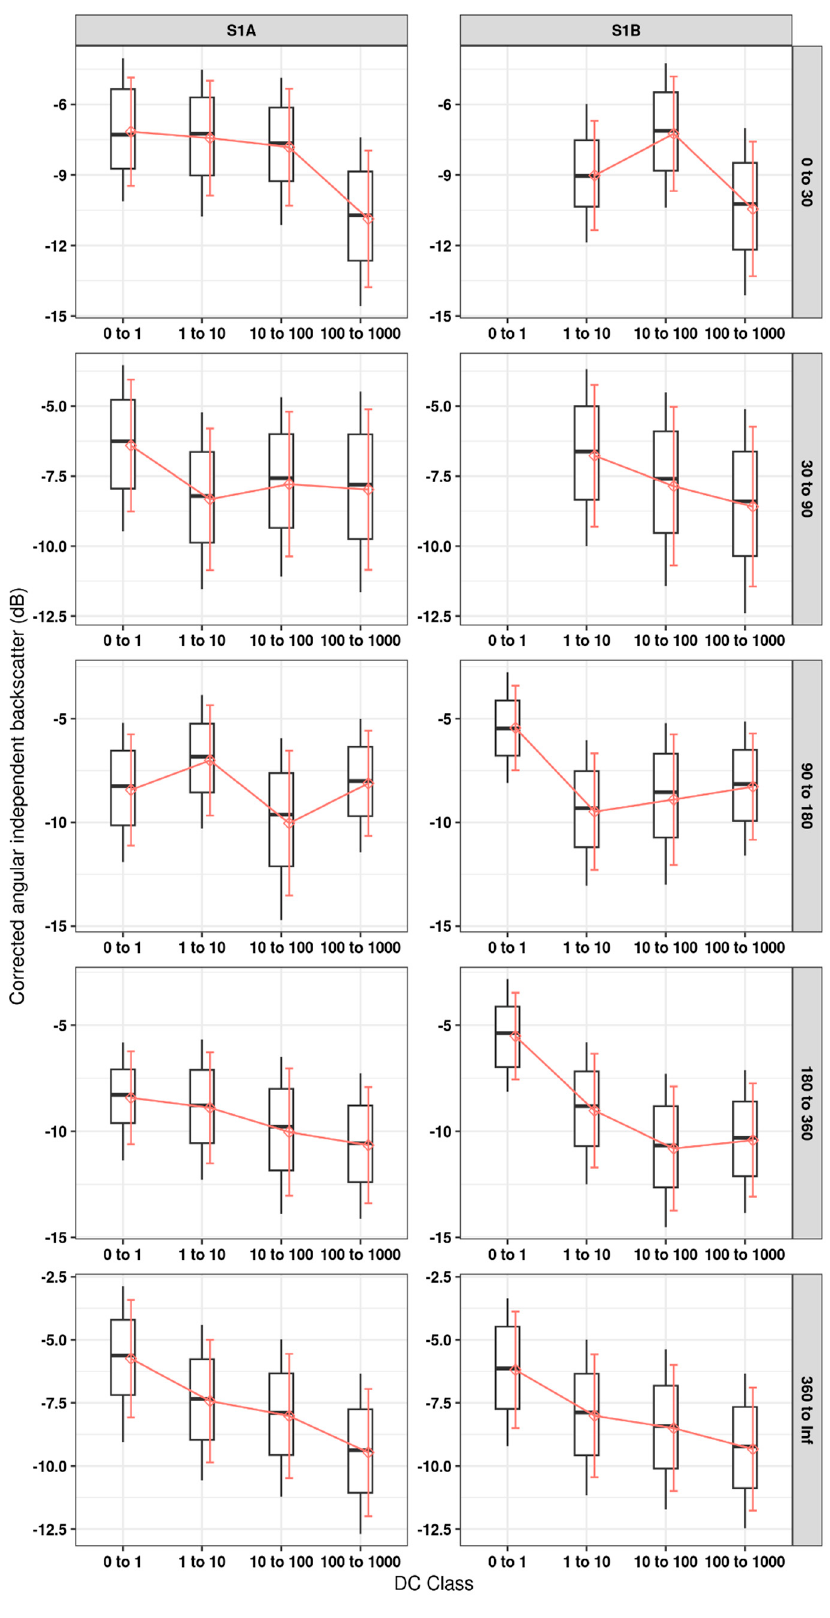
Figure 9. Distribution of corrected Sentinel-1 C-VH backscatter, grouped by DC class with rows representing the days from the fire event and columns the two Sentinel-1 sensors A and B.